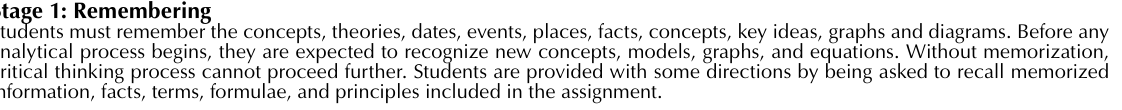
Table 1. The six-stage critical thinking process and description